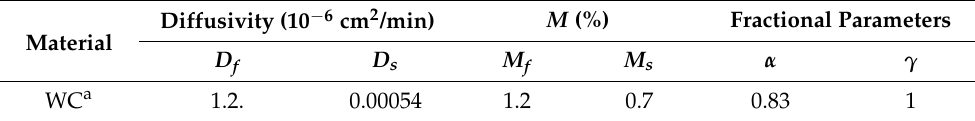
Table 3. Moisture diffusion parameters for 3D woven composite.